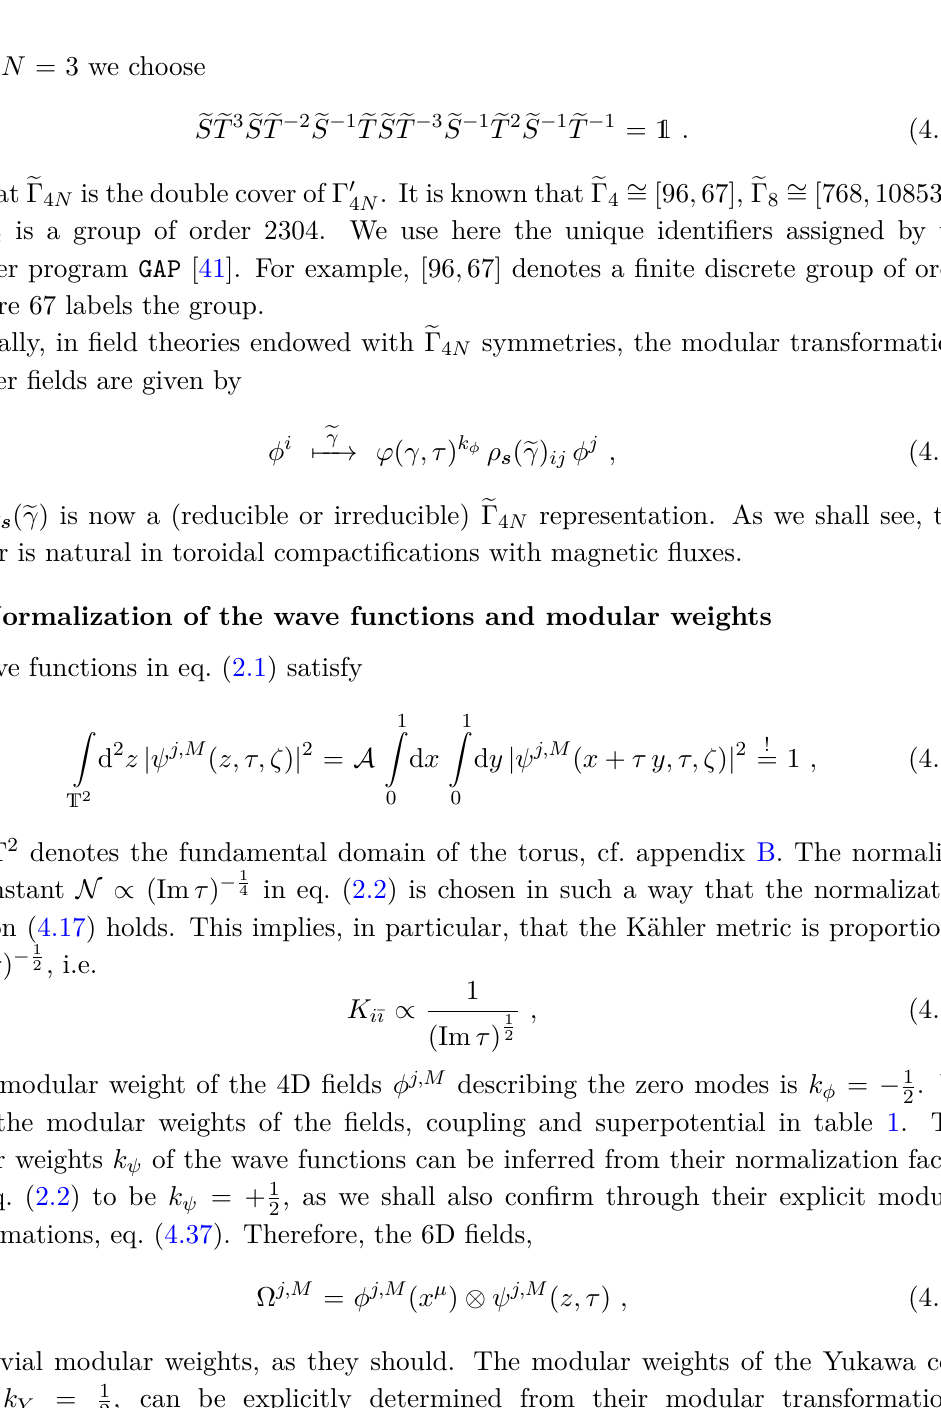
Table 1. Modular weights of the T 2 wave functions ψ j,M , 4D fields φ j,M , 6D fields Ω j,M , Yukawa couplings Y ijk , and superpotential W